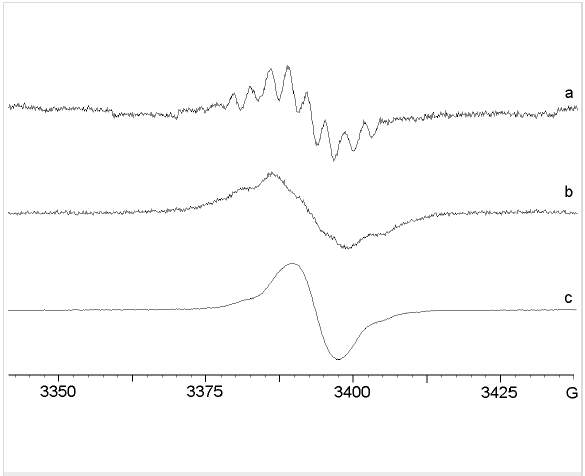
Figure 6: EPR spectra after In-, Ga- and Al-promoted reactions of azide 8 . (a) intermediate from InCl 3 treatment of 8 at 260 K in DCM and CH 3 CN (4:1). (b) spectrum from GaCl 3 treatment of 8 at 300 K in DCM/pentane. (c) spectrum from AlCl 3 treatment of 8 at 300 K in DCM.